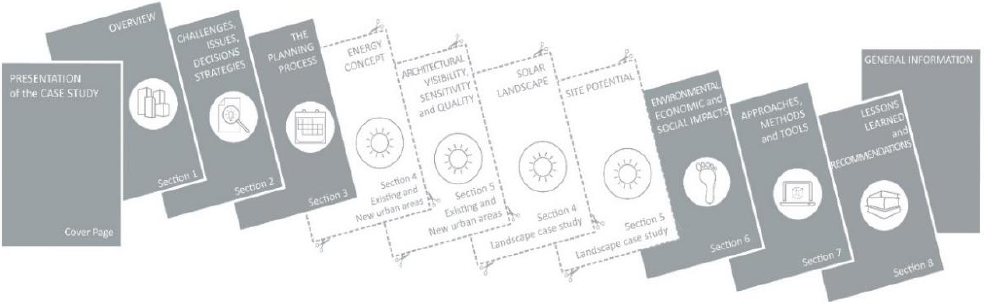
Figure 1. Representation of the different sections of the template used. In full color, the sections compiled for all the cases, while the optional ones are shown in white.